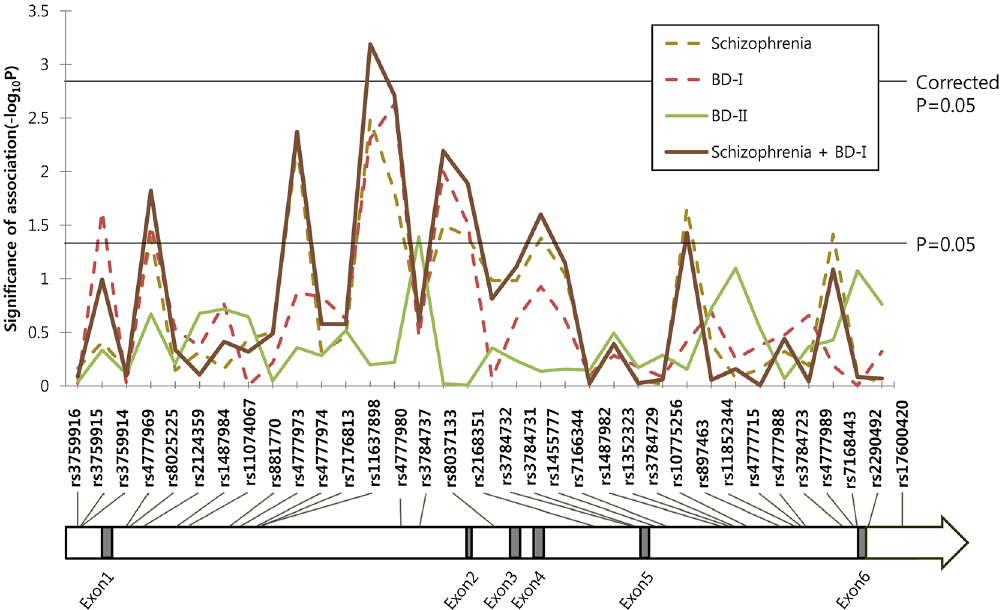
Fig 1. Association pattern between ST8SIA2 tag single nucleotide polymorphisms (SNPs) and schizophrenia and bipolar disorder under the dominant model. – Log of p -values are represented on the y-axis with relative location of the SNPs in the gene on the x-axis. Two horizontal lines indicate nominal and corrected p -values of 0.05.